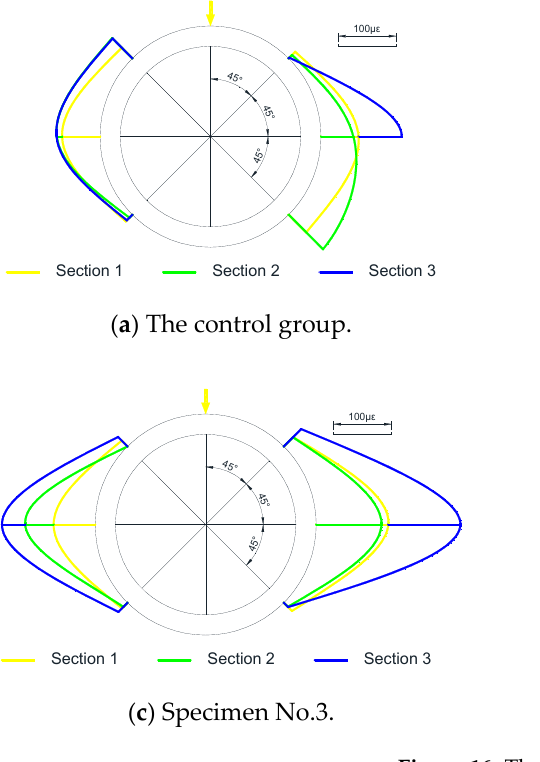
Figure 16. The strain of the pieces.